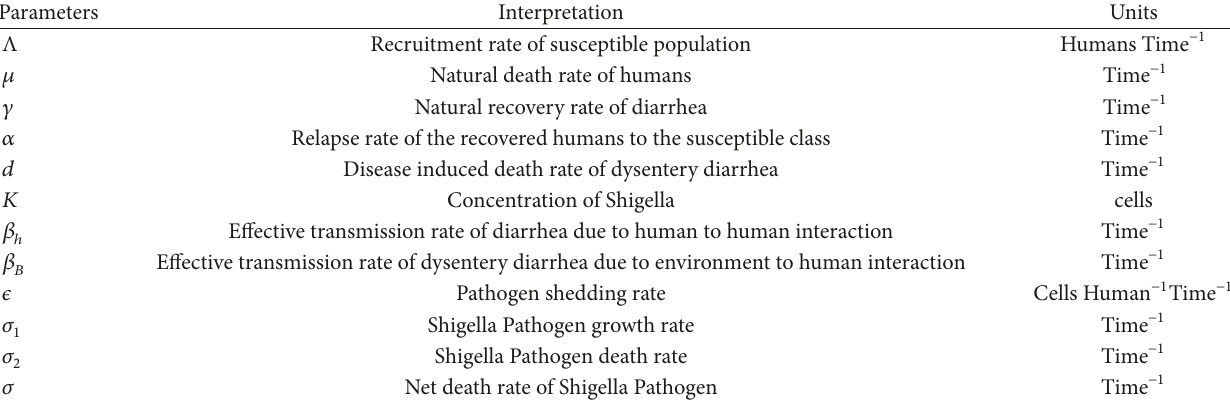
Table 1: Description of parameters of the model equation